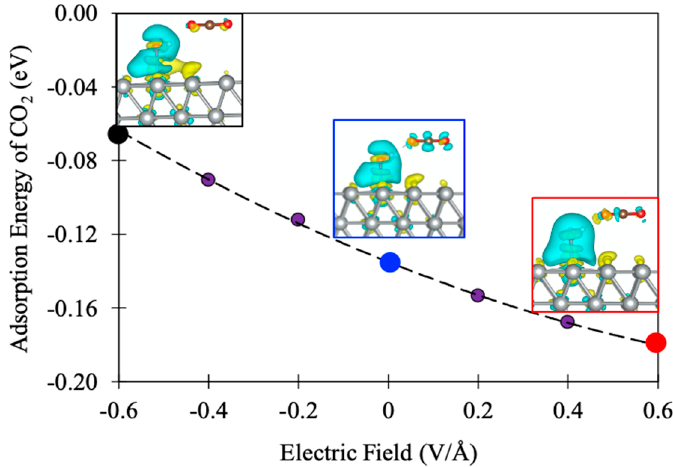
Figure 2. Illustration how an external electric field affects the adsorption strength of CO 2 when water is co-adsorbed on a Ni (111) surface. Red, brown, white, and grey spheres and O, C, H, and Ni atoms, respectively. The yellow or blue areas represent a gain or a loss of electrons at an isosurface of 0.001 electrons/Bohr 3 .